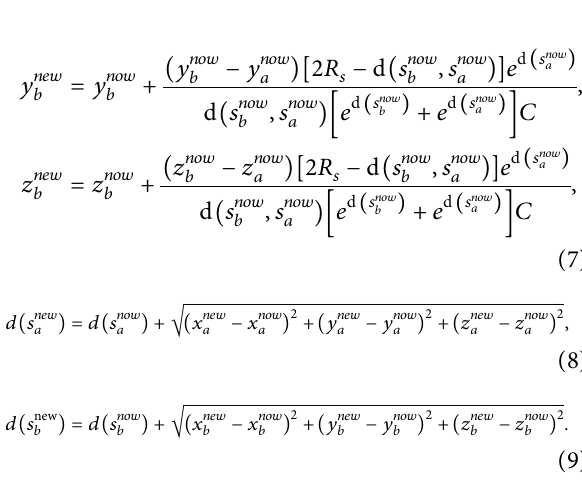
Figure 1: Coverage effect in different